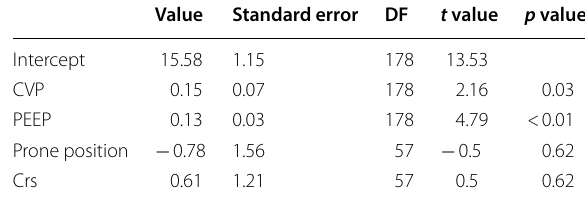
Table 3 Linear mixed model estimation on